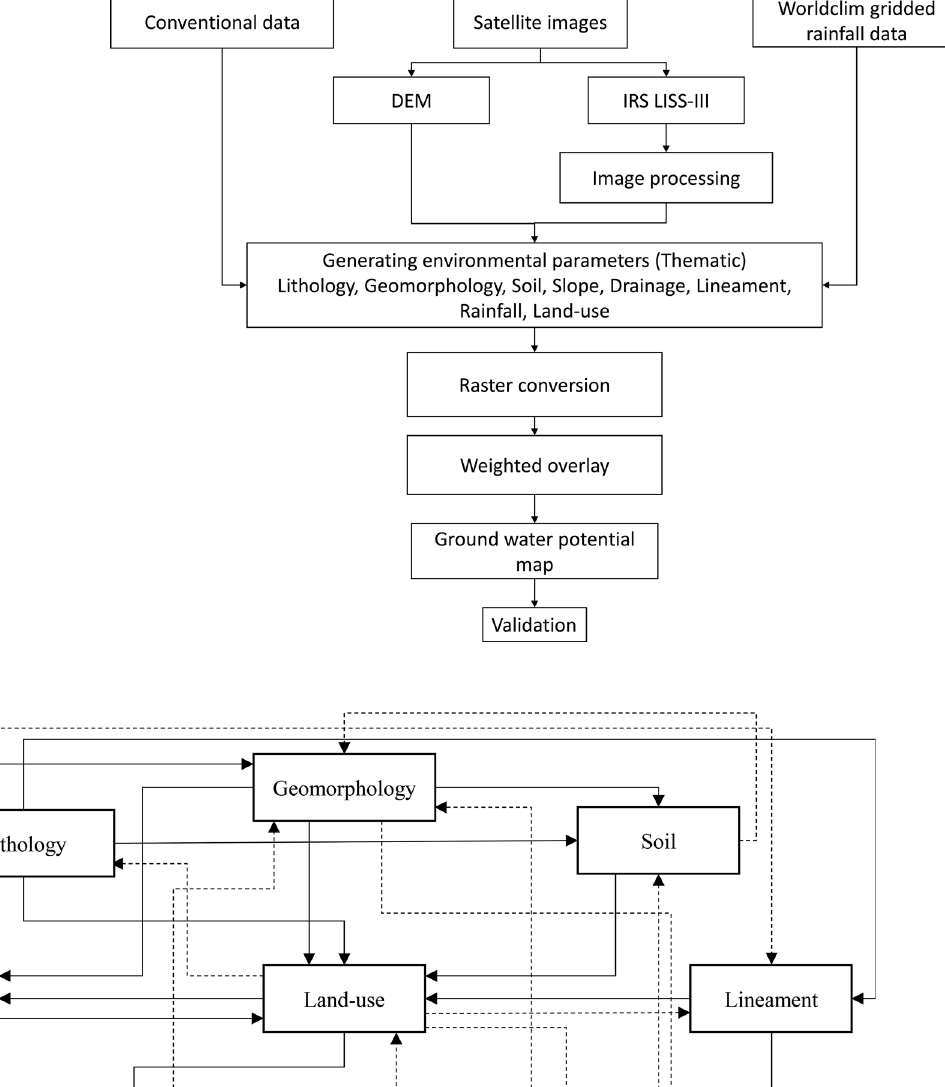
Fig. 2 Methodology considered for the present study